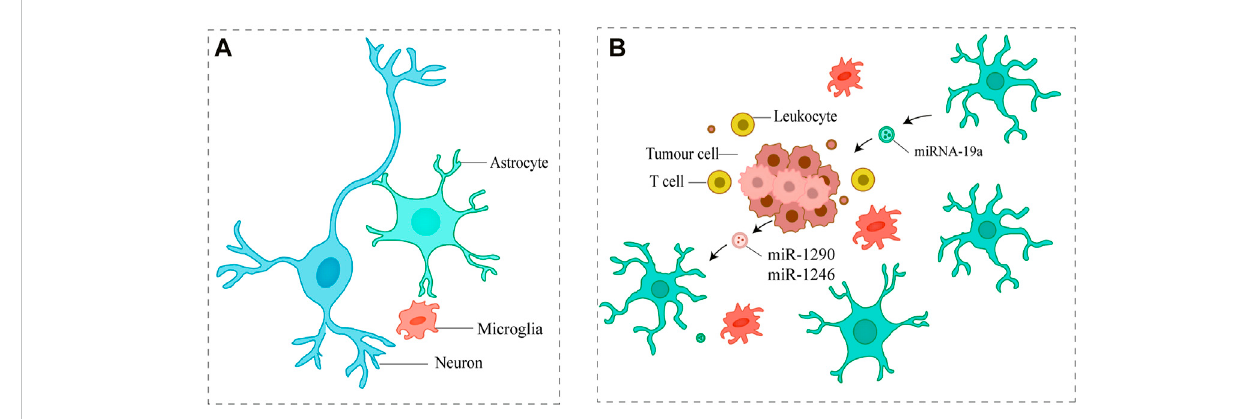
SmallEVspromotetheproliferationofmetastatictumorcells (A) Majorcelltypesinthebrain (B) Metastatictumorcellscommunicatewithastrocytes via small EVs, which ultimately promote metastatic tumor cell proliferation.